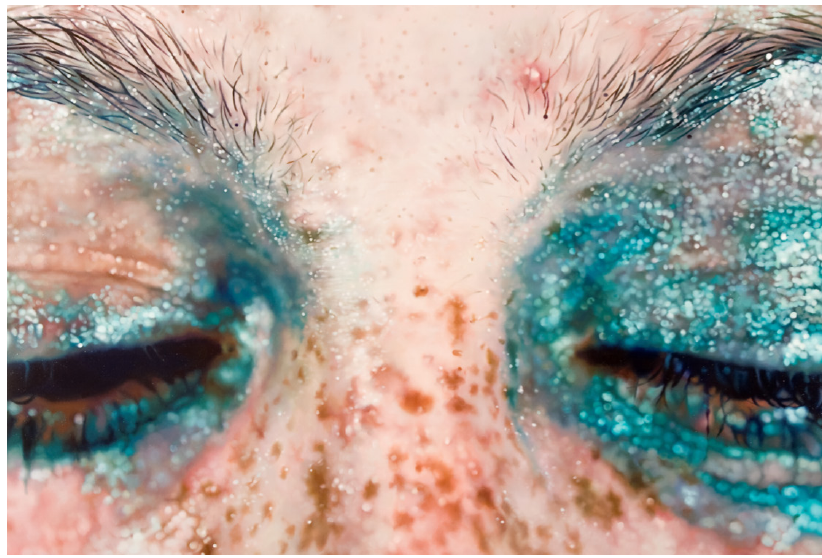
Fig. 3 Marilyn Minter, Blue Poles , 2007, enamel on metal, 60 x 72 inches. Courtesy of the artist and Salon 94, New York. © Marilyn